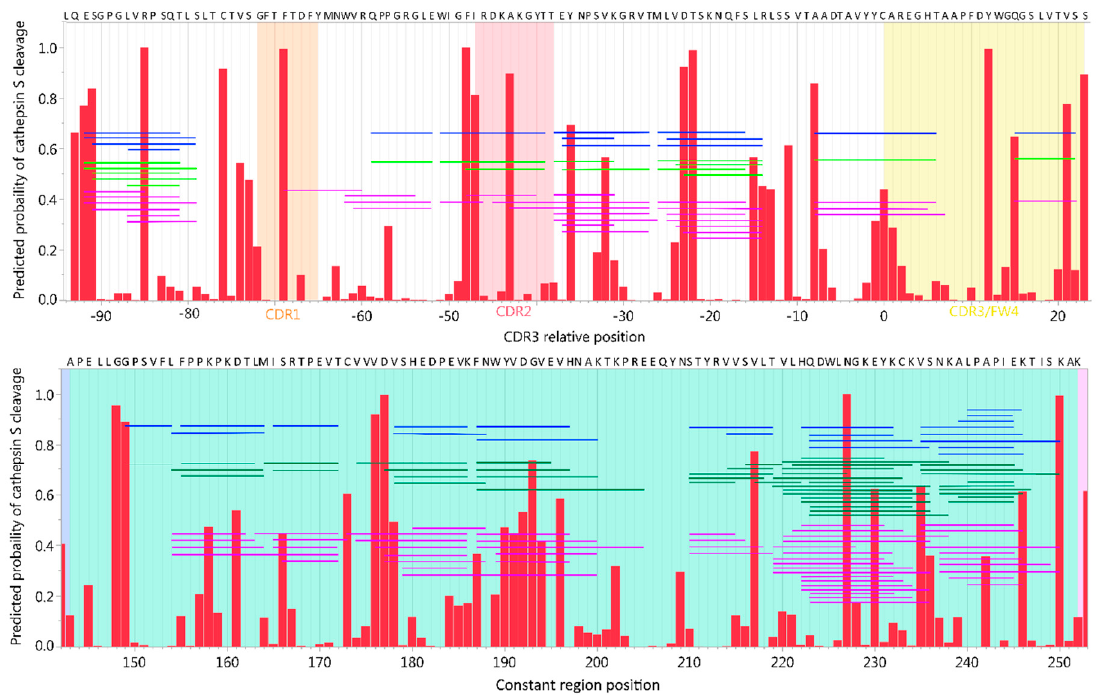
Figure 5. Detected peptides overlap with predicted cleavage sites. Predicted cleavage probability (x-axis) by cathepsin S in variable (upper panel) and constant heavy 2 (CH2) (lower panel) region of alemtuzumab. The vertical bars indicate the predicted position of P1 ′ of a P1-P1 ′ cleavage bond, and thus the first amino acid after a cut. Horizontal bars each indicate unique peptides detected starting at a P1 ′ and ending at a P1, as identified by nLCMS after 6 (blue), 24 (green), and 30 (purple) hours.